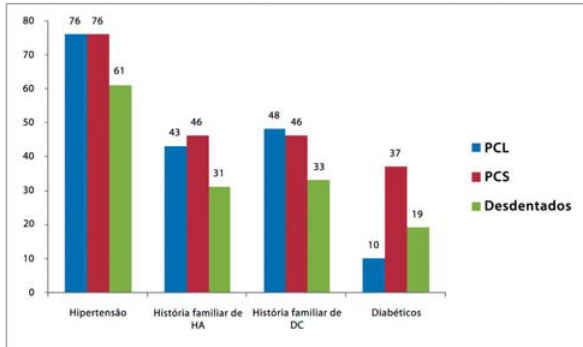
Fig. 3 - Parâmetros clínicos dos pacientes com doença coronariana com e sem periodontites crônicas. HA = Hipertensão arterial; DC = Doença coronariana; PCS = Periodontite crônica grave; PCL = Periodontite crônica